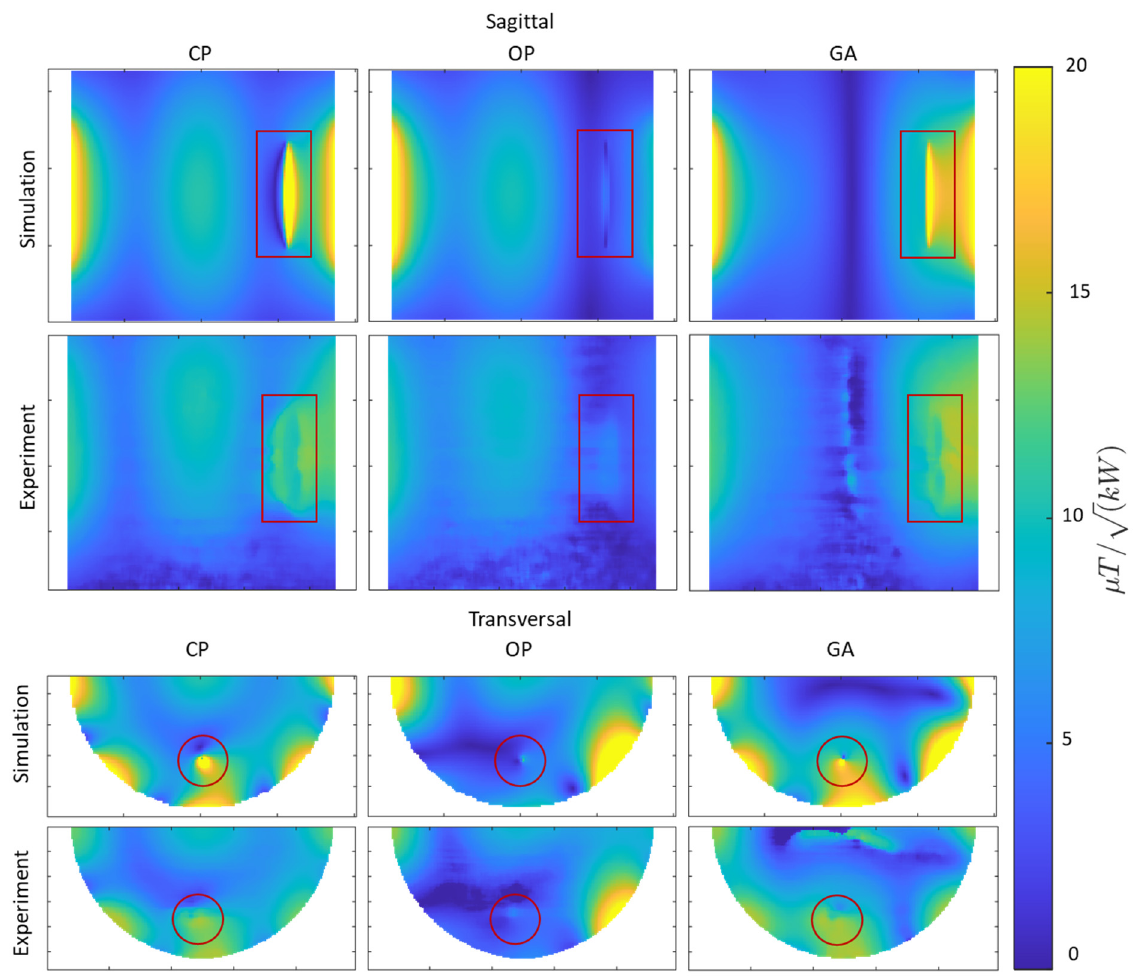
Figure 5. Simulated and experimental results obtained for 𝐵 (cid:2869)(cid:2878) mapping using CP-, OP-, and GA- based transmission field shimming algorithms. The top two rows show sagittal 𝐵 (cid:2869)(cid:2878) maps (covering the entire implant including tips). The bottom two rows show transversal 𝐵 (cid:2869)(cid:2878) maps (covering the regions with most pronounced RF distortion) derived from simulations and phantom experiments.